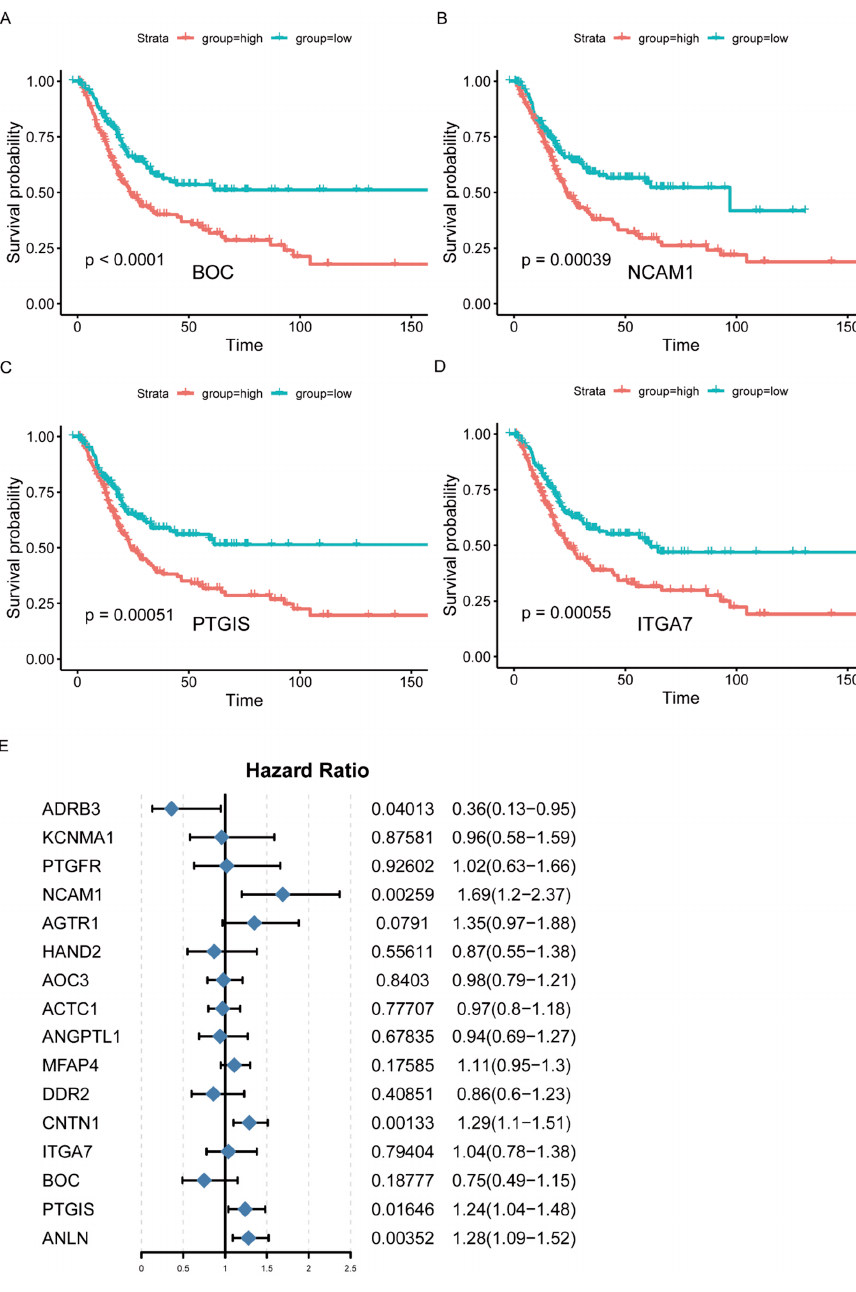
Figure 3. Identification of hub IRGs associated with BC. ( A – D ) Kaplan–Meier survival curves of hub IRGs in BC patients from TCGA database (top 4). ( E ) Multivariate Cox regression analysis of hub IRGs.